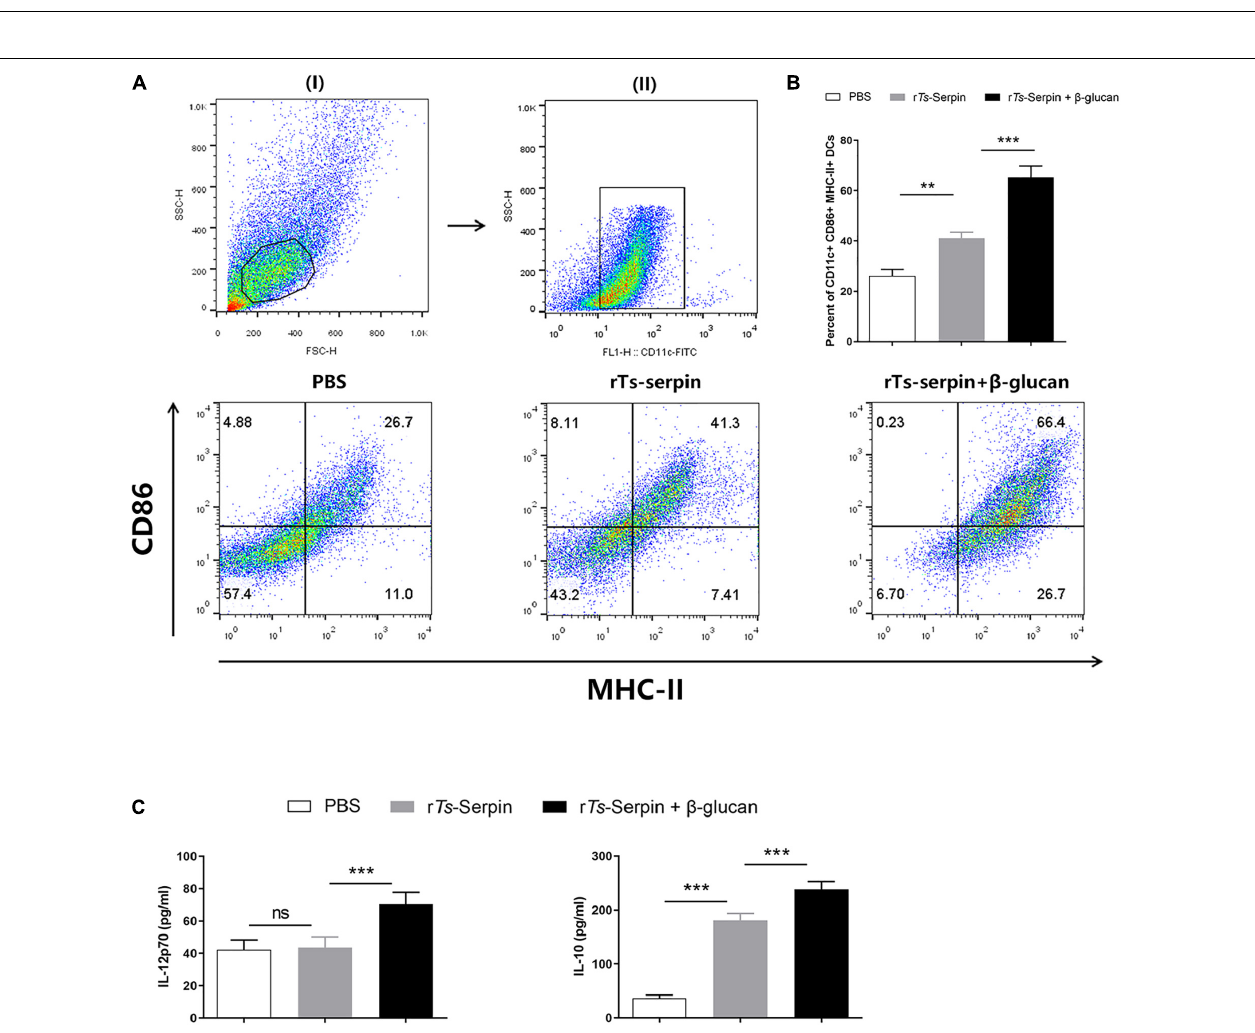
FIGURE 4 | DC phenotype induced by β -glucan + rTs-Serpin. Immature DCs were treated with r Ts -Serpin (10 µ g/mL) or combination of r Ts -Serpin and β -glucan (50 µ g/mL) in vitro for 24 h. (A) (I) gating on viable cells and (II) gating on CD11c + cells. (B) Expression of CD11c + CD86 + MHC-II + cells were measured. (C) Cytokines (IL-12p70 and IL-10) levels in the supernatant were quantified by ELISA Data represent mean ± SD deviations ( n = 3) of the results from three individual experiments * P < 0.05, ** P < 0.01, and *** P < 0.001 vs. the control groups.